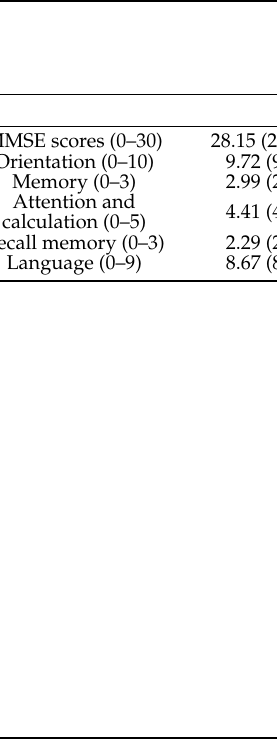
Table 2. Relationships between Delayed Word Recall Test (DWRT) and Mini Mental State Examination (MMSE) and its components.